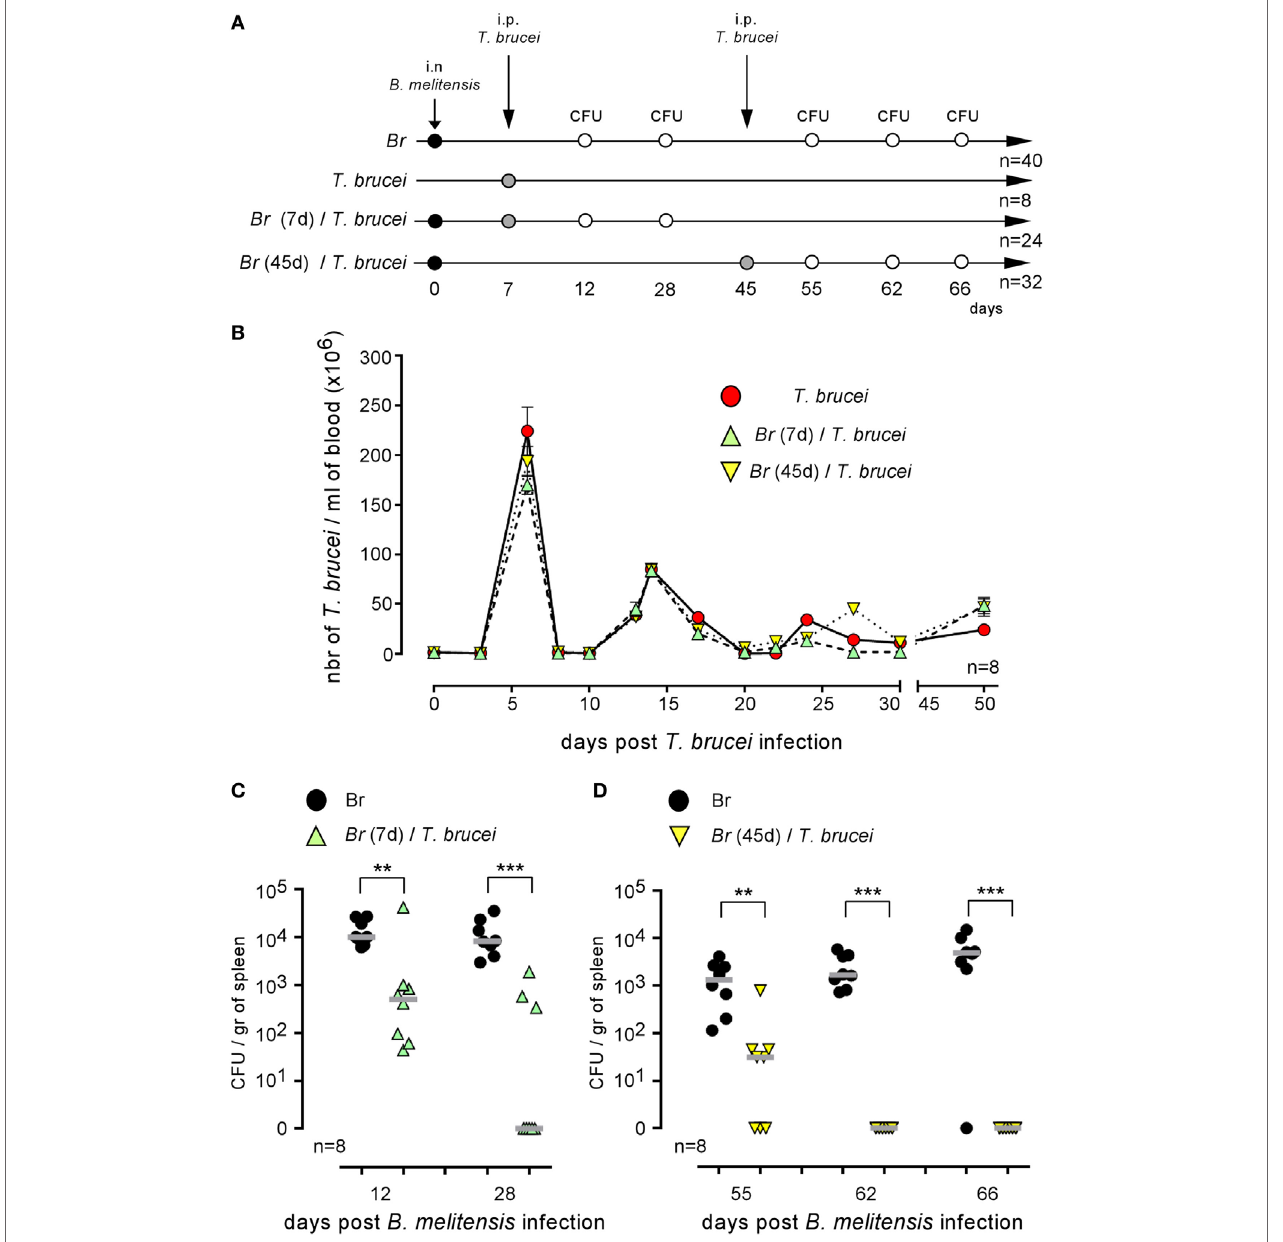
FigUre 3 | Trypanosoma brucei co-infection strongly reduced the CFU level of Brucella melitensis in the spleen. Wild-type C57BL/6 mice were infected i.n. with PBS or 2 × 10 4 CFU of mCherry- B. melitensis and, at 7 or 45 days postinfection, received an i.p. injection of PBS or 5,000 T. brucei or PBS alone, as described in panel (a) . The data in panel (B) represent the number of T. brucei per milliliters of blood. The data in panels (c,D) represent the number of colony-forming units per gram of spleen. Note that, to avoid a possible effect of repeated blood sampling, mice that were bled to measure the number of parasites in the blood were not used to measure the number of Brucella CFUs in the spleen. Gray bars represent the median. n denotes the number of mice used for each group (** p < 0.01, *** p < 0.001). These results are representative of at least two independent